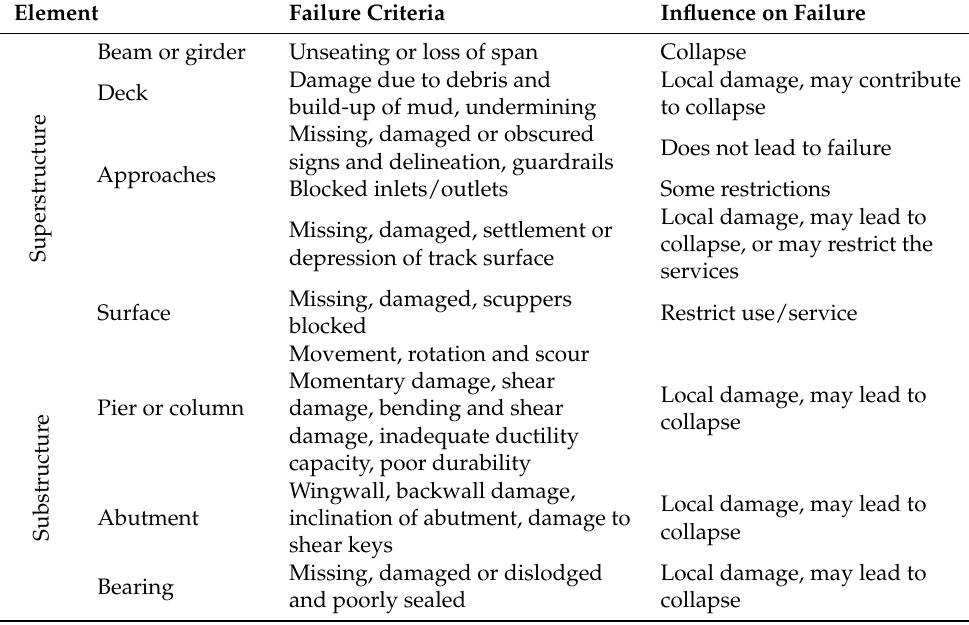
Table 7. Potential Failure Criteria for Bridges in Flood Events, modified from [78]. Element Failure Criteria Influence on